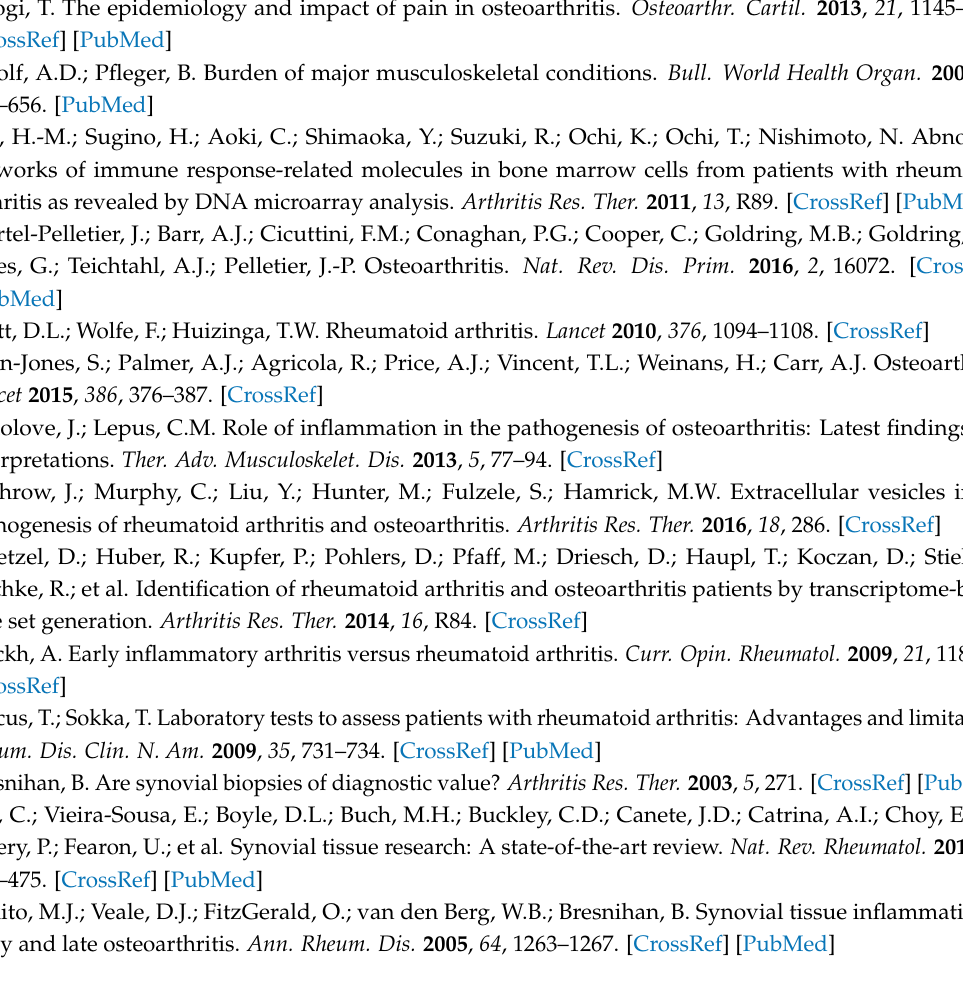
Table S1: Microarray data sets employed in the current study. Table S2: GO and KEGG enriched pathways in RA versus OA. Table S3: GO and KEGG enrichment pathways in RA versus normalcy and OA versus normalcy. Table S4: Biological functions of 16 differential biomarker candidates. Figure S1: Principal component analysis of two batch effects removed data sets. (a) Set A (GSE1919, GSE39340, and GSE36700), (b) Set B (GSE55457, GSE55584, and GSE55235). Figure. S2: The STRING protein–protein interaction network of differentially expressed genes. (a) Upregulated network. (b) Downregulated network. According to STRING, red, green, blue, purple, yellow, light blue, and black strings demonstrated the presence of fusion, neighborhood, co-occurrence, experimental, text mining, database, and co-expression evidence, respectively. Data S1: Descriptive analysis and visualization of 16 predictors in RA versus